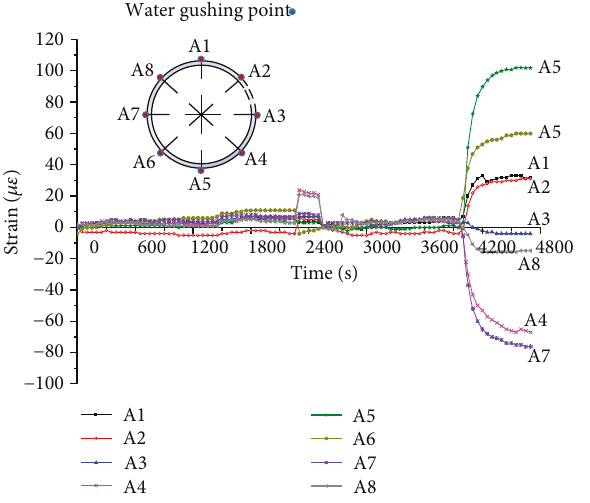
Figure 14: Strain-time curves of A1 – A8 on the A section.